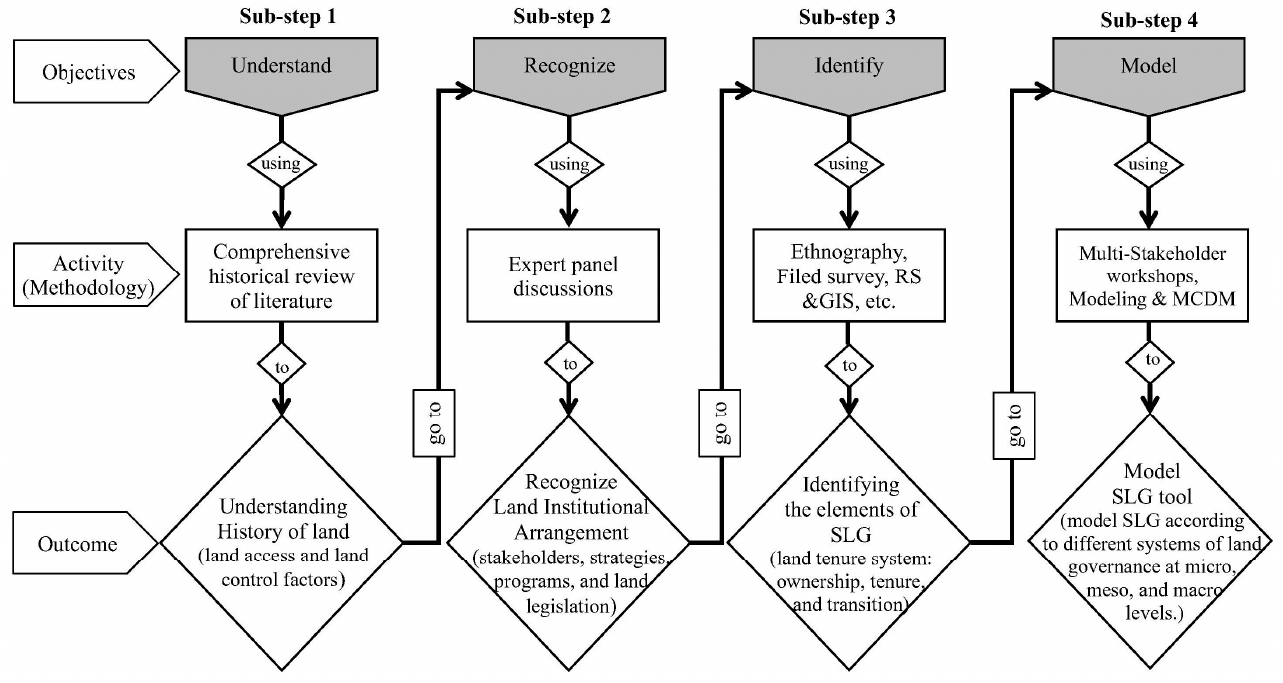
Figure 1. The proposed smart land governance (SLG) system.